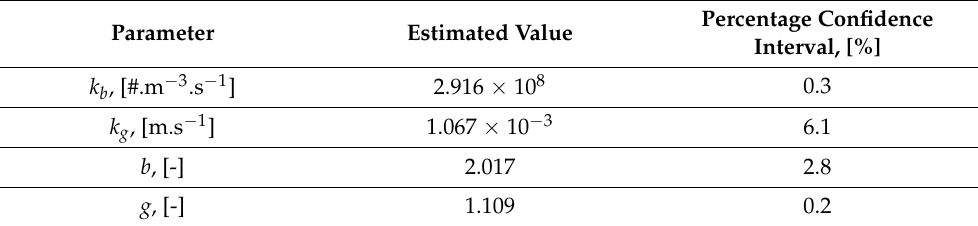
Figure 7. ( a ) Experimental CSDs of the final-time solid product and seed crystals; ( b ) experimental vs. modeling CSDs of the final-time product from the 1st crystallization. vs. modeling CSDs of the final-time product from the 1st crystallization. Table 1. Estimated kinetic parameters with 95% confidence